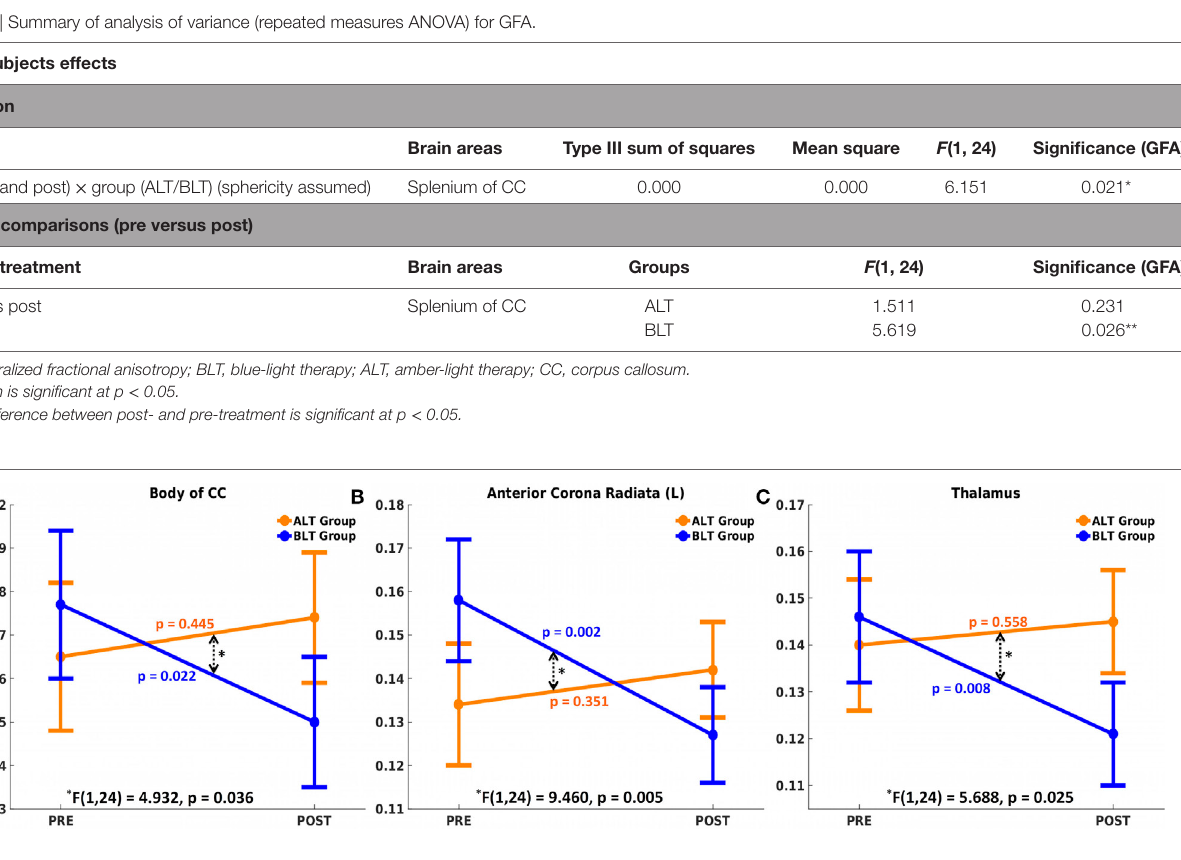
FigUre 3 | Mixed analysis of covariance of normalized quantitative anisotropy (NQA). Fibers crossing three brain areas, the body of the corpus callosum (CC) (a) , left anterior corona radiata (ACR) (B) , and thalamus (c) showed significant time (pre and post) × group (ALT/BLT) interaction in normalized QA (NQA). Compared to baseline, pairwise comparison showed significant reduction in NQA for these three regions following BLT, but not following ALT. BLT, blue-light therapy; ALT, amber-light therapy.